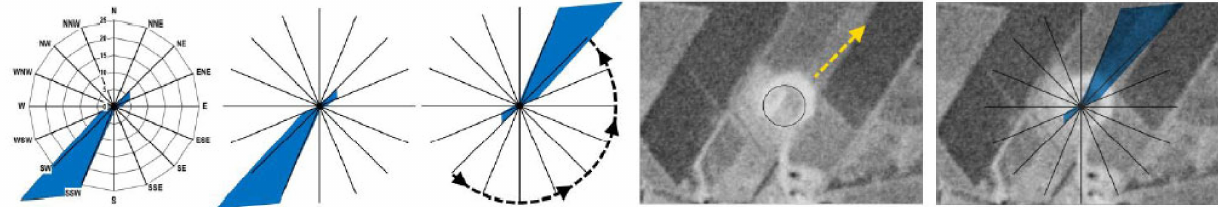
Figure 9. Example of the match between the direction frequency rose of the IB04-Son Ferriol station (Bay of Palma, prevailing wind from SW-SSW at 13 UTC) and a threshing floor whose wind-plume (sea breeze) is also from